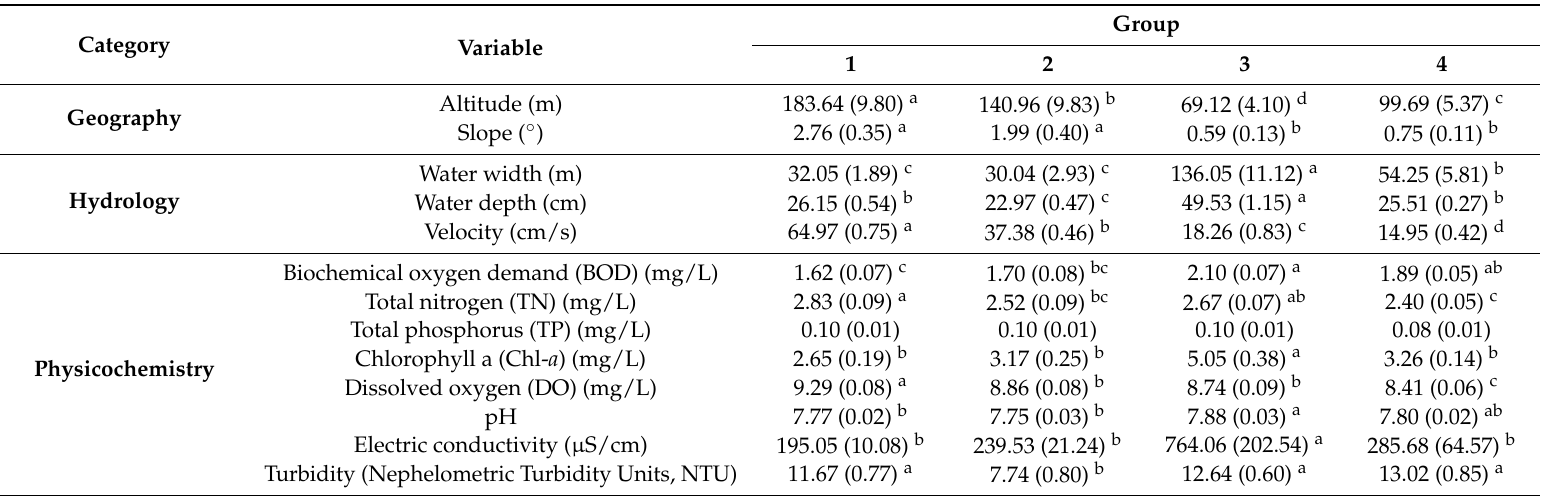
Table 1. Differences (mean with standard error) in environmental factors among four different groups defined through a hierarchical cluster analysis. Different letters in the same row indicate significant differences between the groups based on Tukey’s multiple comparison tests ( p < 0.05). Dissolved oxygen (DO); biochemical oxygen demand (BOD); total nitrogen (TN); total phosphorus (TP); chlorophyll a (Chl- a